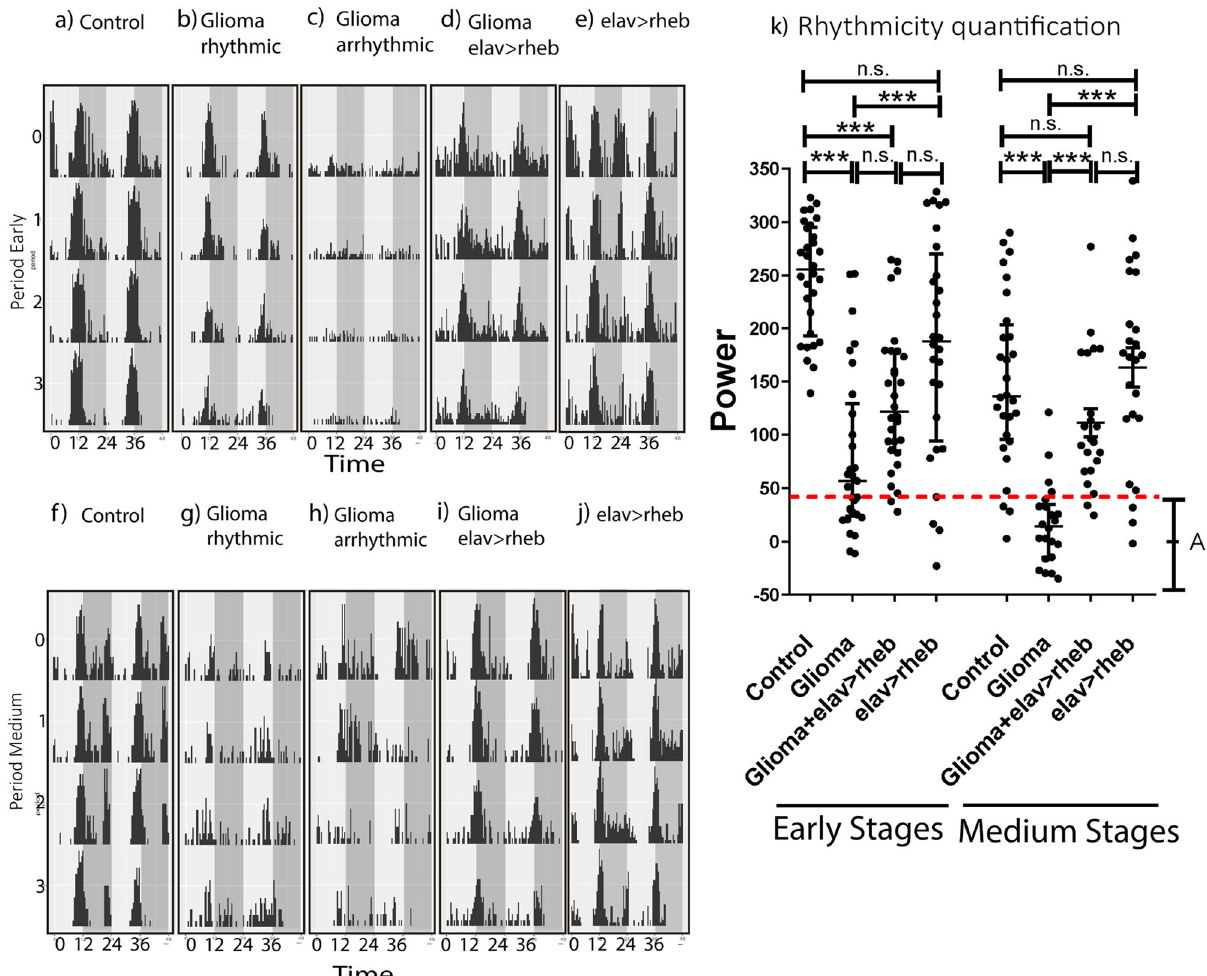
Fig. 1 The rescue of glioma-induced neurodegeneration restored circadian rhythms. Representative individual locomotor activity pro fi le from one particular animal of each indicated genotypes showing 5 days under free running (D:D) conditions for ( a , f ) control ( b , c , g , h ) glioma, ( d , i ) rescued glioma (by means of neuronal rheb over-expression) and ( e , j ) rescued control fl ies. Gray bars indicate subjective night. For GB two different actograms are depicted, exemplifying rhythmic and arrhythmic animals. For early GB ( a – e ), the locomotor activity of fl ies during the fi rst 5 days of tumor development was recorded using DAMs, whereas for medium GB ( f – j ), the movement of animals from day 5 to day 10 of GB growth was studied. k A graph representing the individual power for each fl y under different conditions, depicting the median, from at least n > 22 surviving fl ies (ANOVA, post-hoc Bonferroni) (** P - value < 0.01, *** P -value < 0.001). Values below the dotted line were considered arrhythmic (i.e. A). Table 1 Table showing the main circadian values from controls, glioma and rescued glioma fl ies. Total power Rhythmicity Period Early (0d – 5d) n Mean Median SEM Mean